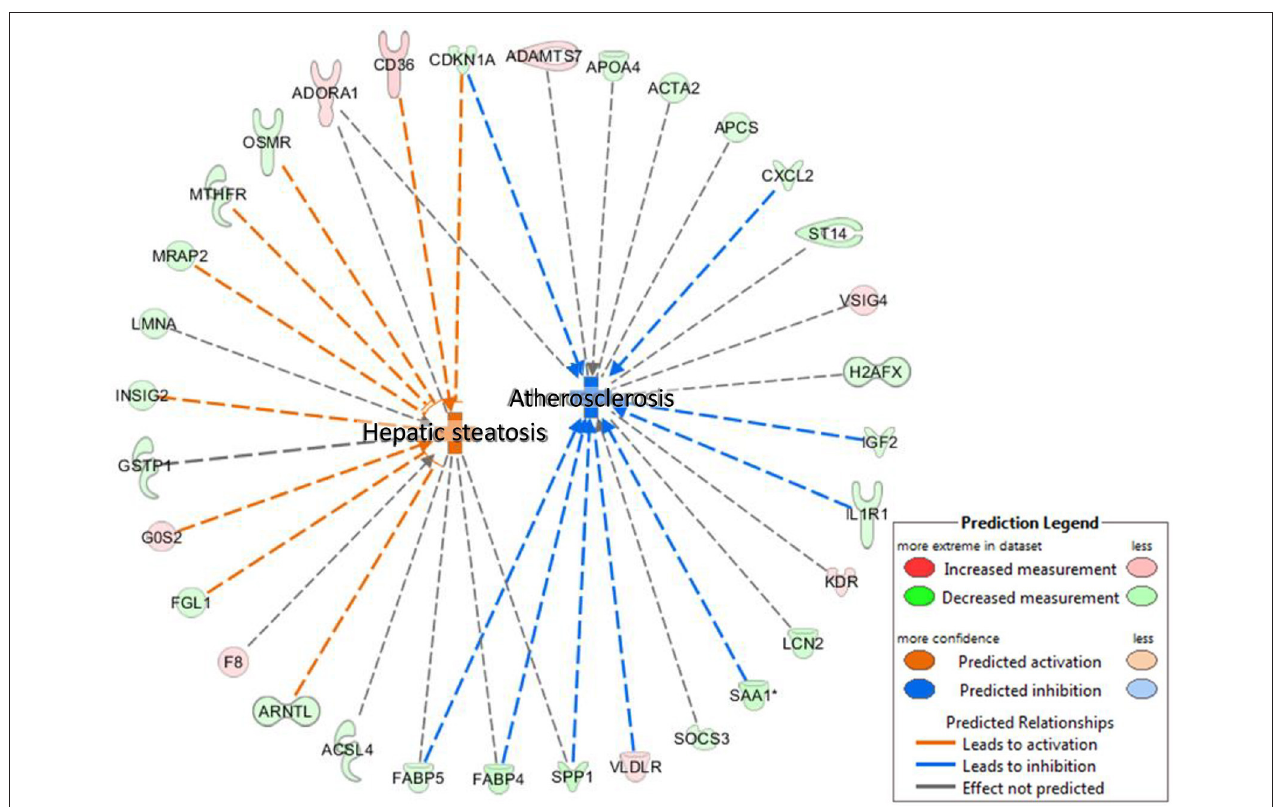
FIGURE 4 | IPA Disease and BioFunctions analysis: hepatic steatosis and atherosclerosis—significantly positively and negatively enriched categories in livers of 10 months old mice developmentally exposed to 1 mg/kg body weight BDE-47.